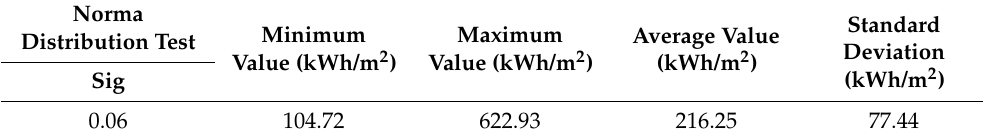
Table 2. The descriptive statistics of annual